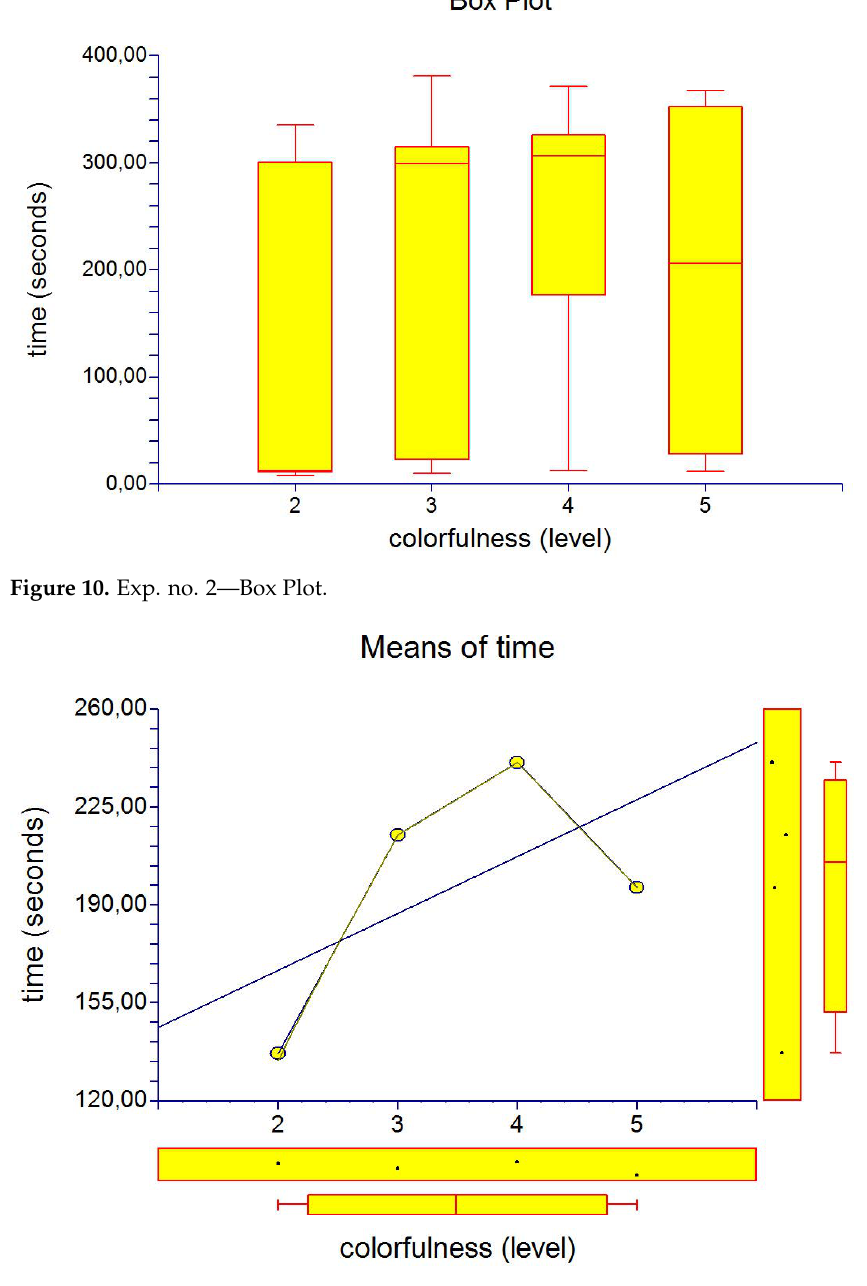
Figure 11. Exp. 2—Computing time